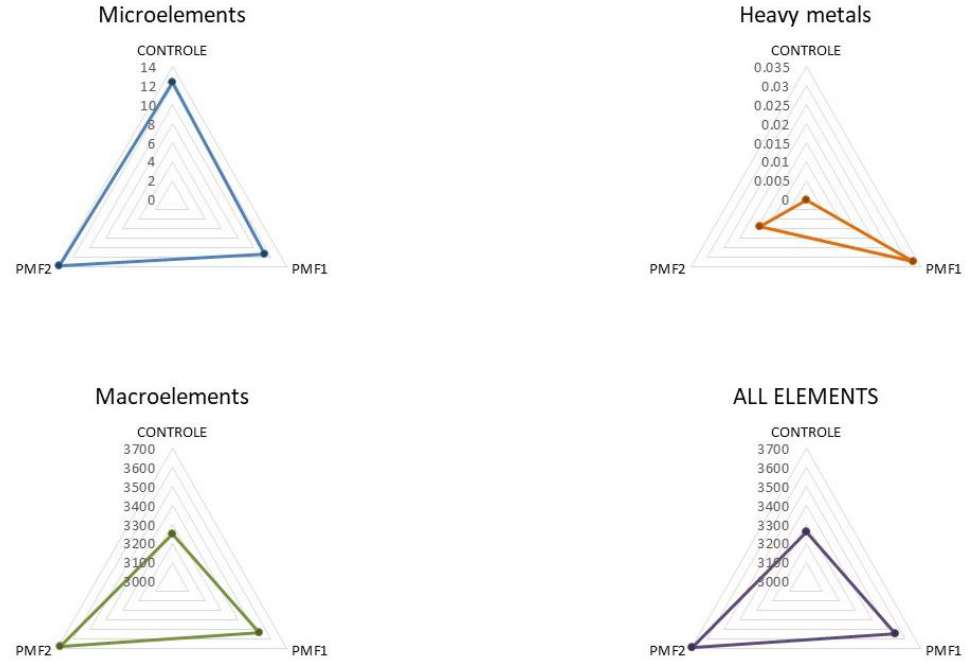
Figure 6. Changes in micro–macro elements and heavy metals and the sum thereof under the influence of the application of doses of pulsating magnetic field for cress sprouts.